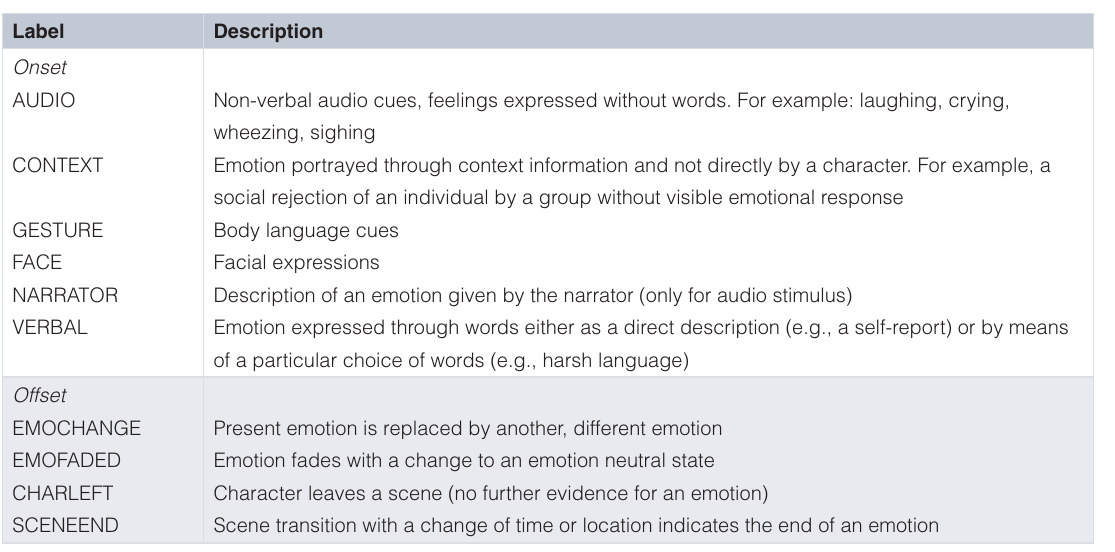
Table 1. Categories for cues indicating the onset or offset of an emotion. Label